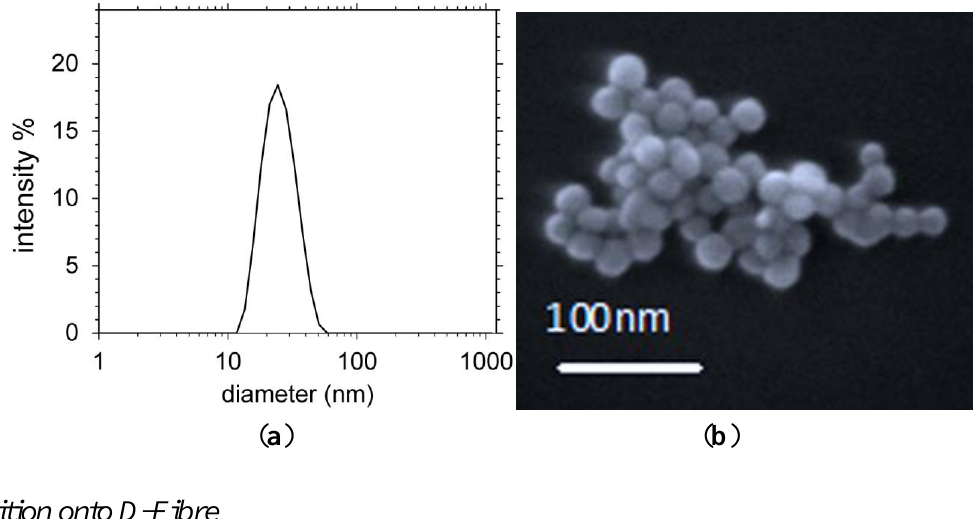
Figure 7. ( a ) Dynamic light scattering (DLS) measurements of silica particle size distribution in H O and ( b ) an SEM image of some of the nanoparticles on a 2